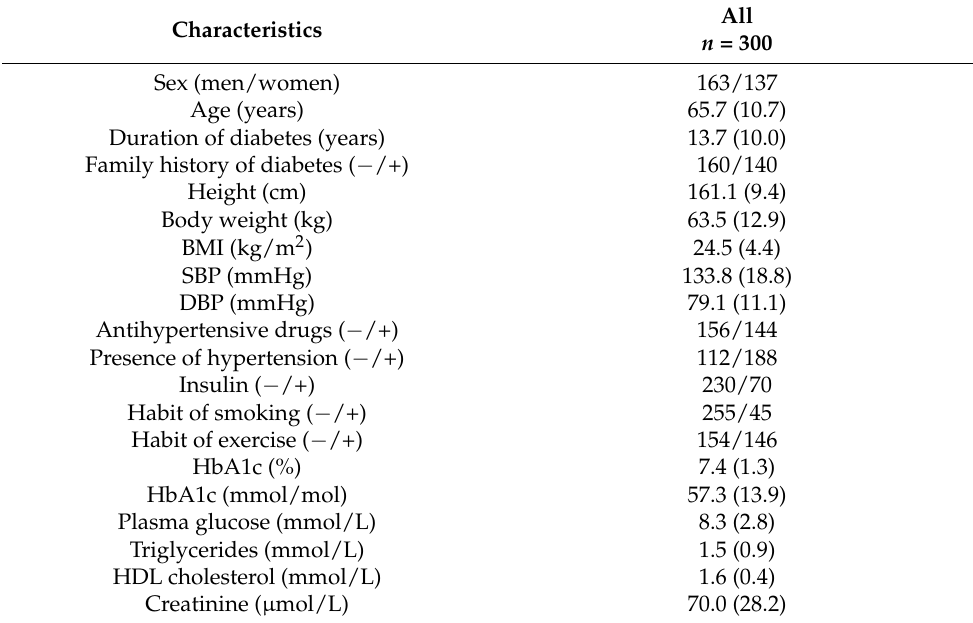
Table 1. Clinical characteristics of study participants.